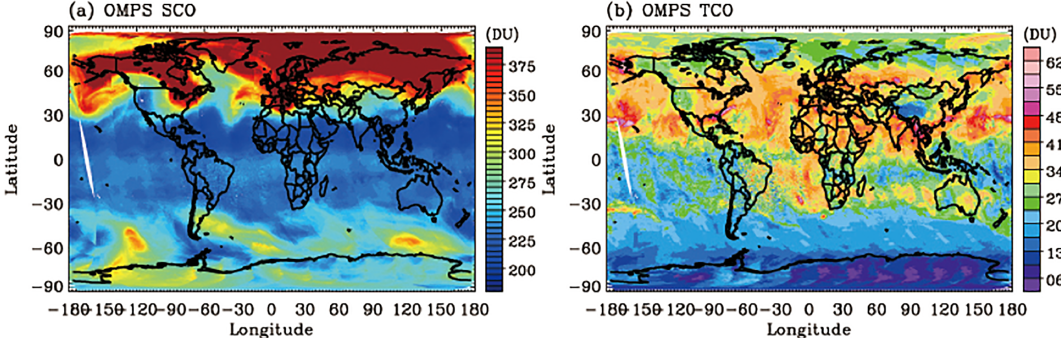
Figure 7. Same as Fig. 5a and b but for OMPS ozone retrievals with soft